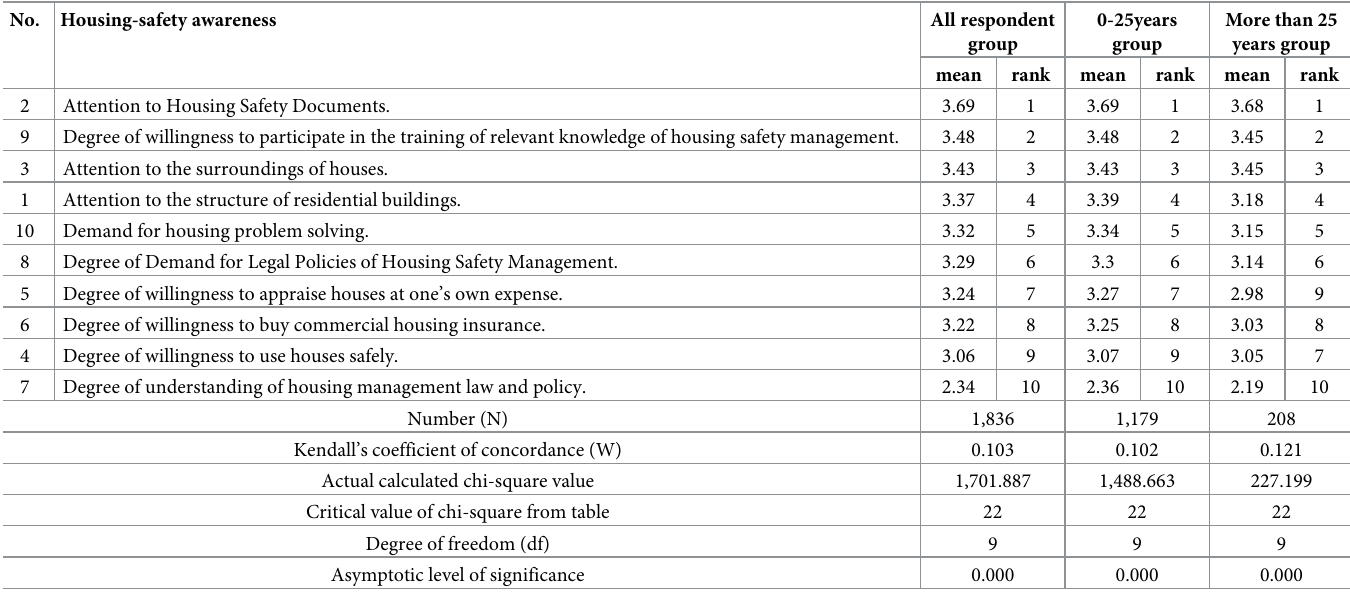
Table 3. Results of the ranking and Kendall’s concordance test for the major building-safety awareness. No. Housing-safety awareness